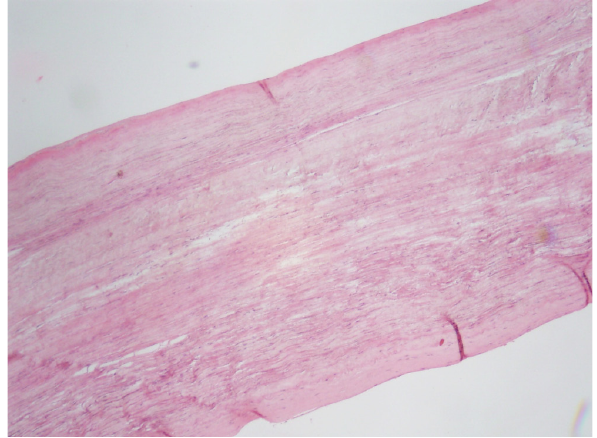
Fig. 8. Microscopy. Trichrome staining. Original magnification 200x. Green color corresponds with fibrotic